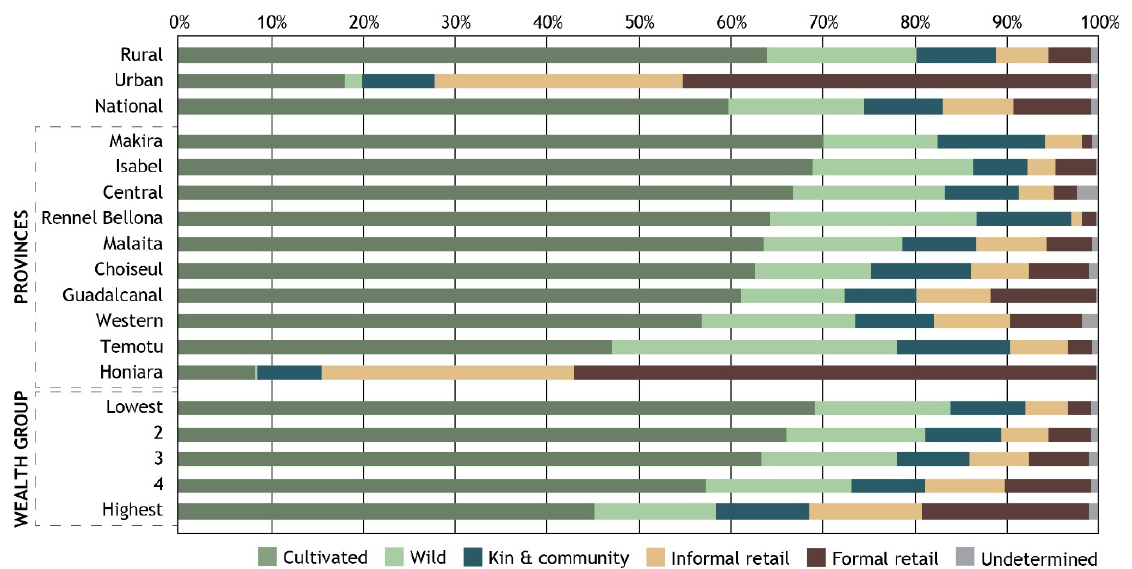
Figure 3. Proportion of total quantity of food acquired from different food environments Nationally, by geographic location and wealth groups.